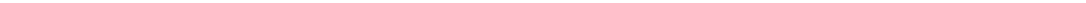
Figure 1: Mechanisms of angiogenesis: sprouting (A) vs intussusception, or splitting (B) . A. VEGF gradients in the extracellular matrix induce the functional specification of endothelial tip cells (in red), which migrate towards the gradient source, and stalk cells (in yellow), which proliferate behind the tip, forming ab-luminal sprouts that fuse together and generate new vessels. B. In the absence of a gradient, all endothe- lial cells respond to VEGF by assuming a stalk phenotype without tip cells. The subsequent proliferation without migration leads to circumfer- ential enlargement of vessels without sprouting followed by formation of intra-luminal endothelial pillars which fuse together and cause longitu- dinal splitting into two new